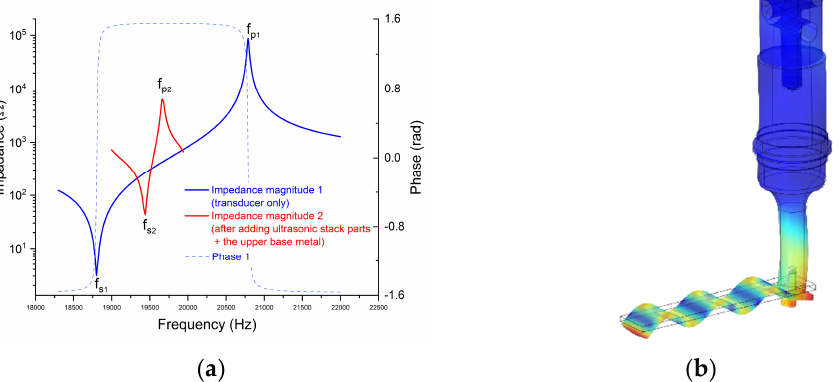
Figure 7. ( a ) Electrical impedance magnitude and phase of the transducer as a function of the frequency: transducer only (1) and after adding the other ultrasonic stack components with the base metal /the active part only (2); ( b ) The vibration mode (unitless) of the attached base metal (in the air at normal temperature).